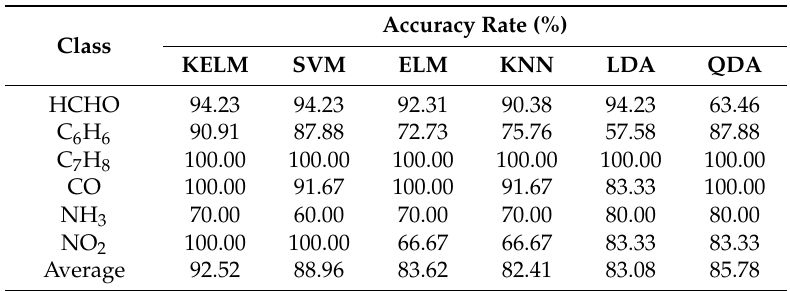
Table 8. Accuracy results of various feature extraction techniques and classification models for datasets in